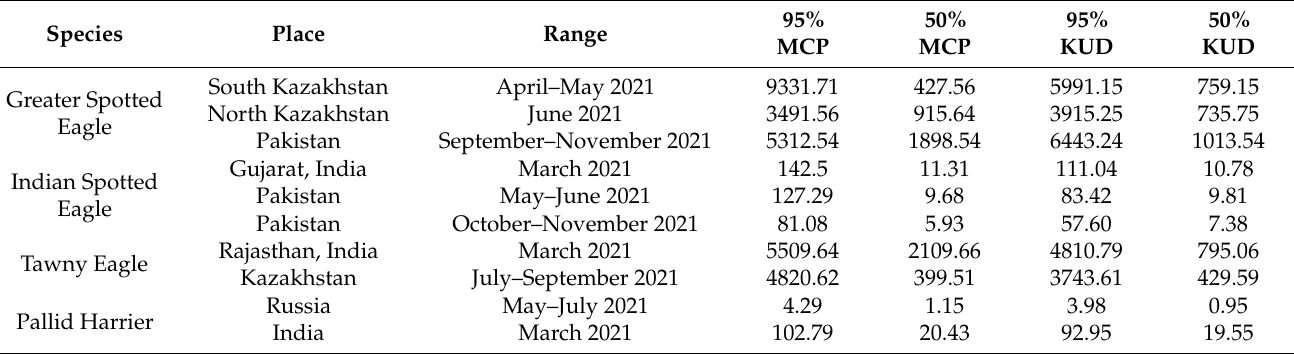
Table 2. Home range size (in km 2 ) estimated as minimum convex polygons (MCPs) and kernel utilisation distribution (KUD) of four raptor species. Home ranges were calculated using R package adehabitatHR and were constructed across their breeding and non-breeding ranges.